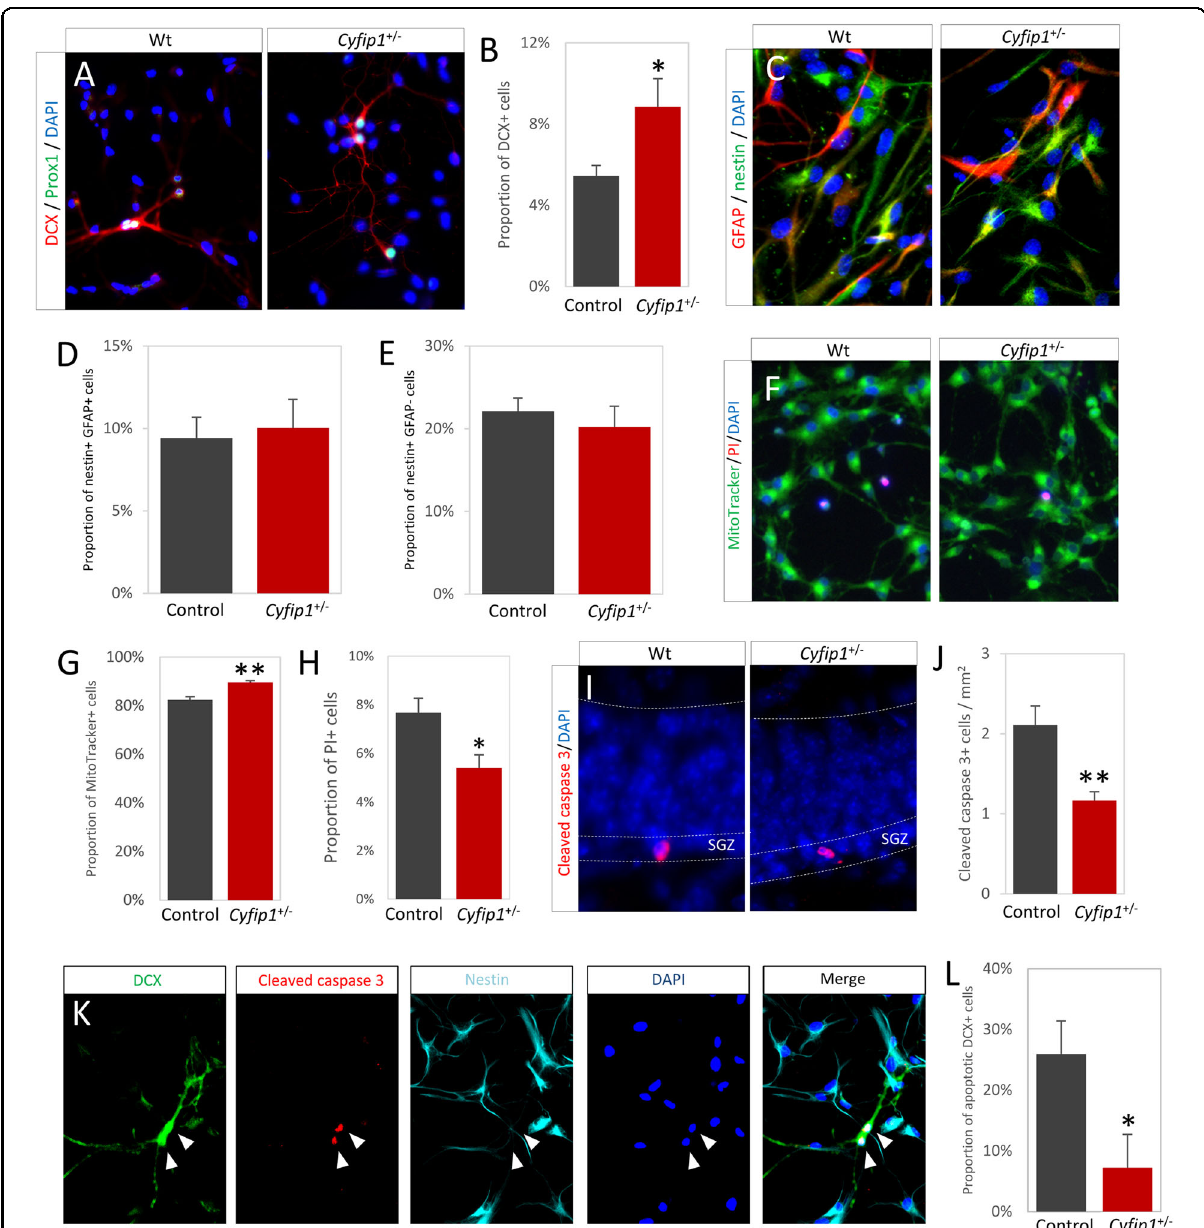
Fig. 2 Primary hippocampal progenitor cultures prepared from P7 to P8 brain con fi rm ex vivo fi ndings and indicate that increased neuronal numbers in Cy fi p1 + / − animals is due to reduced apoptosis. A Immunoreactivity for immature neuron marker DCX and hippocampal marker Prox1 con fi rm cultures contain hippocampus-derived developing neurons. B Cy fi p1 + / − animals showed a signi fi cantly higher proportion of DCX + cells in the total DAPI + population ( n = 17). C Representative staining for progenitor markers GFAP and nestin showed cultures contained a mixed population of progenitors at differing stages of development. D There was no signi fi cant difference in the proportion of early GFAP + /nestin + cells ( n = 36). E The proportion of later GFAP − /nestin + cells ( n = 36) was also unaffected. F Live imaging showed cultures are largely comprised of healthy, MitoTracker + cells, with some dying PI + cells. G A small but signi fi cant increase in the proportion of MitoTracker + cells was observed in the Cy fi p1 + / − cultures ( n = 15). H Conversely, a signi fi cant decrease in the proportion of PI + cells was seen in the Cy fi p1 + / − cultures ( n = 14). I Examples of apoptotic cells in the dentate gyrus, as marked by immunoreactivity for cleaved-caspase 3. J Cy fi p1 + / − animals ( n = 13) have signi fi cantly fewer apoptotic cells than wild-type animals ( n = 12). All data are shown as mean± SEM. K Immunoreactivity for apoptotic marker cleaved-caspase with DCX and nestin showed speci fi c neuronal apoptosis in primary cultures. Arrowheads indicate an apoptotic neuron. K The fraction of immature neurons undergoing apoptosis was signi fi cantly lower in the Cy fi p1 + / − cultures ( n = 17). L Representative image of apoptotic cells in the dentate